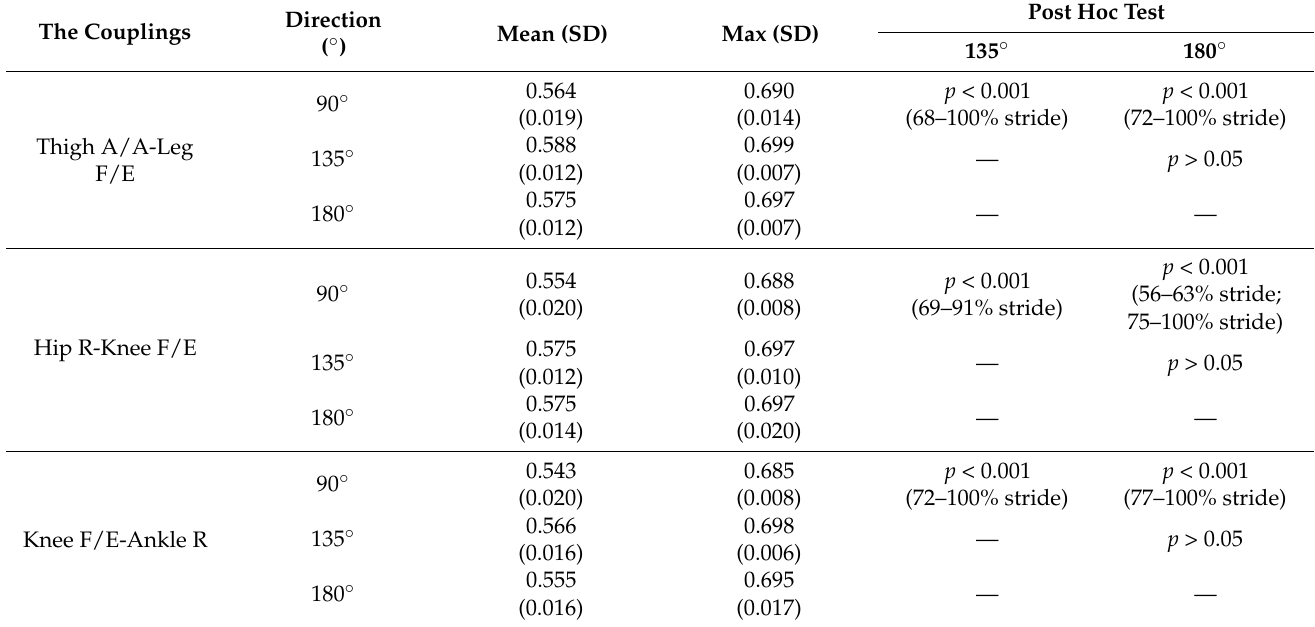
Table 2. Vector-coding coefficients, mean (standard deviation), and Post hoc